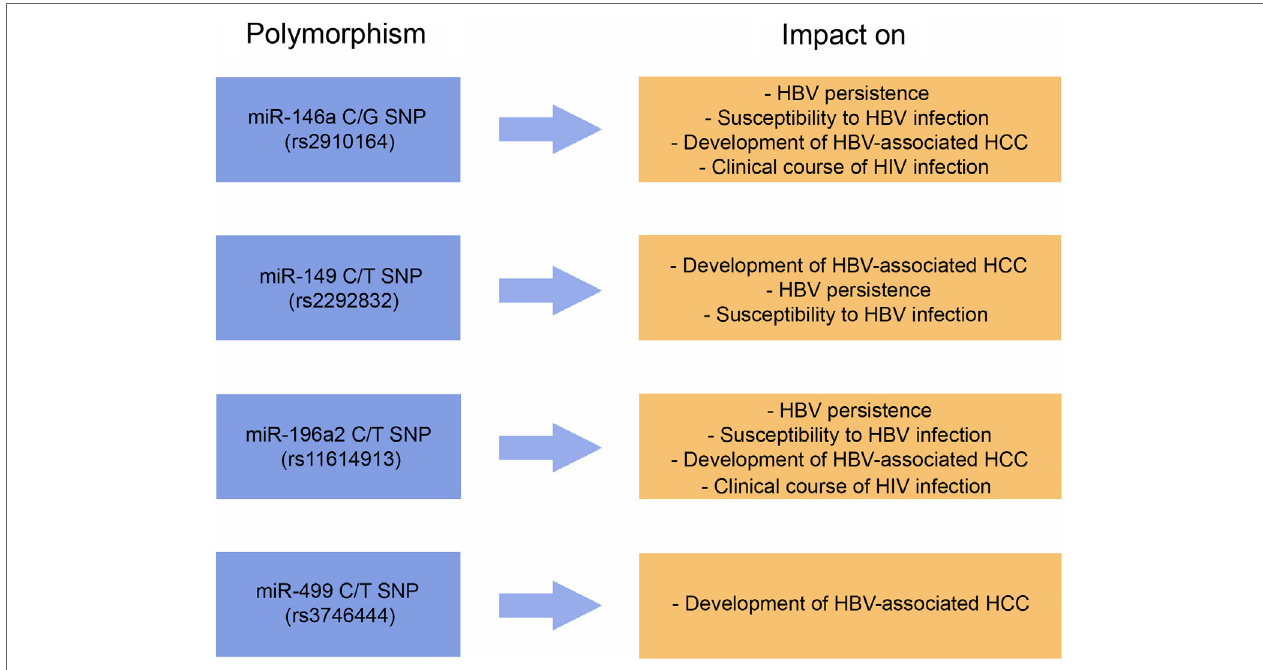
FiGURe 4 | Summary of the main miRNA-related polymorphisms discussed in this review and their impacts on viral diseases. See text and Tables for